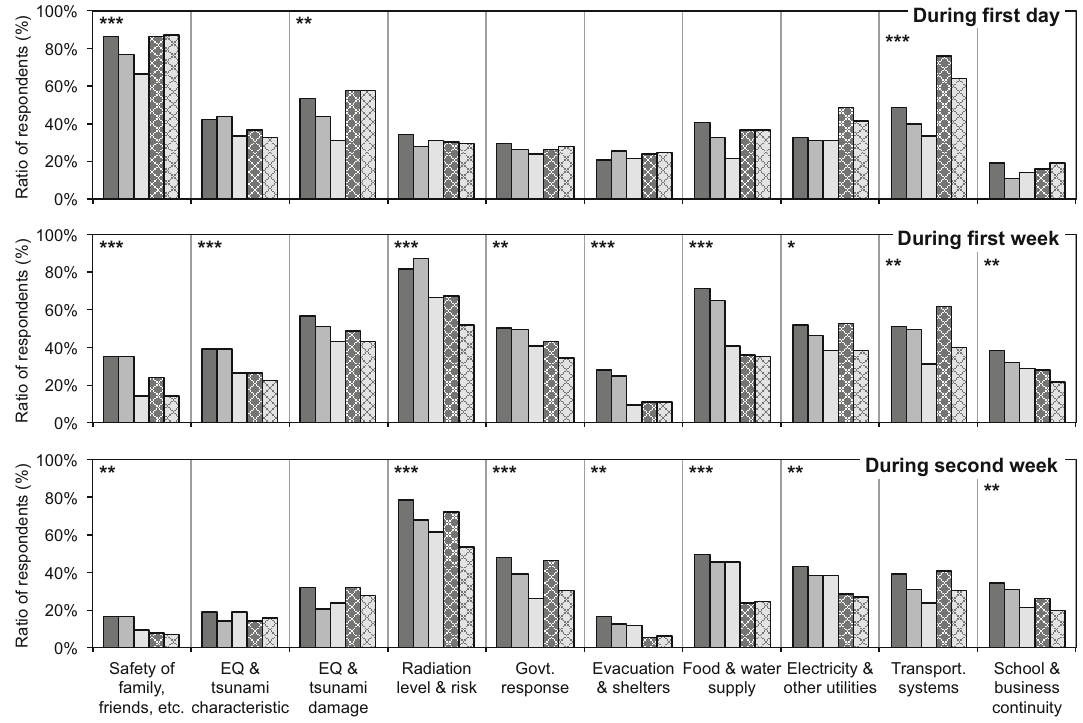
Fig. 4 Important types of information over time: first day, first week, and second week after the 2011 Great East Japan Earthquake. Chi square significance codes: *** p \ .001, ** p \ .01, * p \